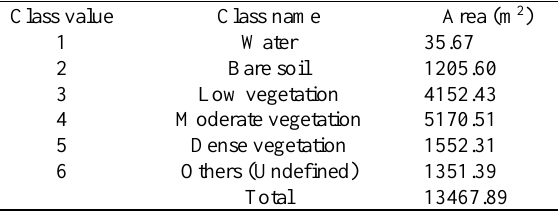
Table 1. Classified land covers based on NDVI